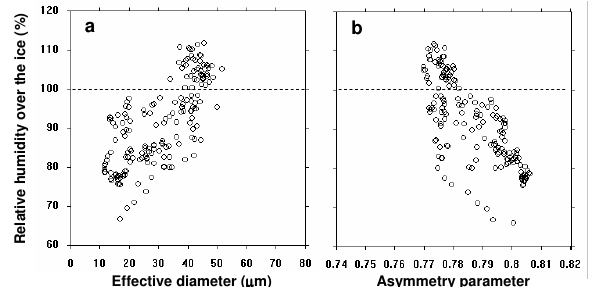
Fig. 12. (a) Effective diameter and (b) asymmetry parameter versus the relative humidity over the ice. The data concerns the overshoot- ing